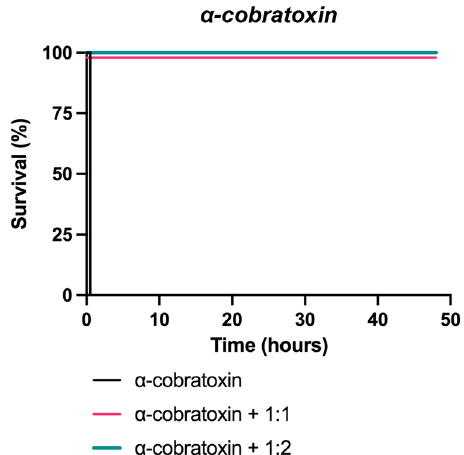
Fig. 5 | Kaplan – Meier survival curves for mice challenged with α -cobratoxin preincubated with or without the antibody 2554_01_D11. Two LD50s of α - cobratoxin ( N. kaouthia ) were preincubated with the antibody, 2554_01_D11, at various neurotoxin:antibody ratios and then administered i.v. into groups of four mice. Controls included mice receiving α -cobratoxin alone (see Materials